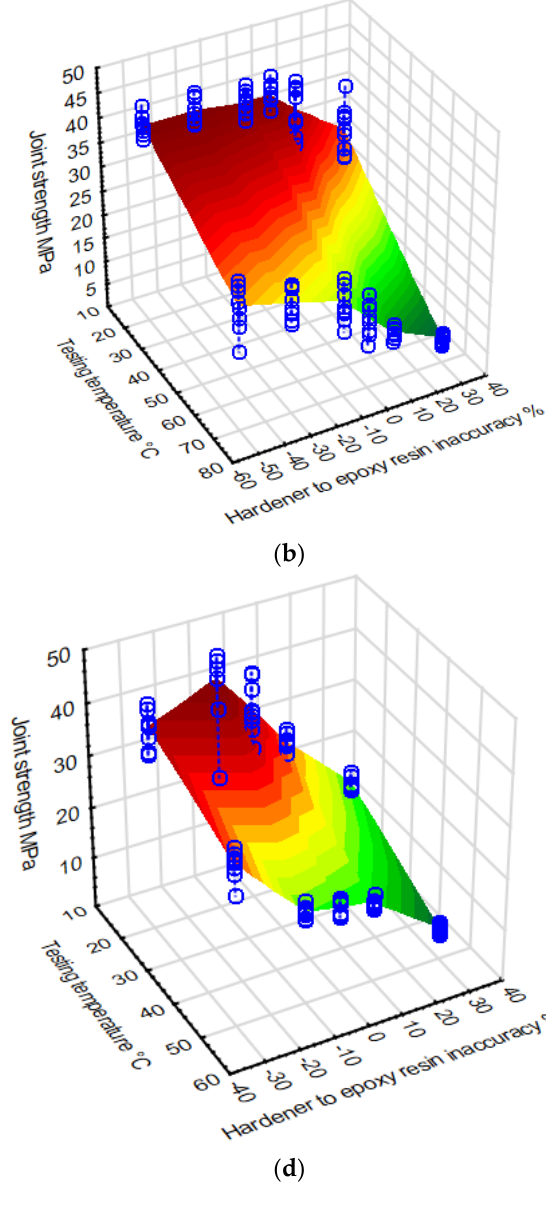
Figure 7. Strength of adhesive joints prepared using the presented adhesives crosslinked under dif- ferent thermal conditions: ( a ) Hysol 9492 cured for 3 days at 20 °C, ( b ) Hysol 9492 cured for 1 h at different thermal conditions: ( a ) Hysol 9492 cured for 3 days at 20 ◦ C, ( b ) Hysol 9492 cured for 1 h at 100 °C, ( c ) Epidian 57/PAC cured for 7 days at 20 °C, ( d ) Epidian 57/PAC cured for 2 h at 100 °C. 100 ◦ C, ( c ) Epidian 57/PAC cured for 7 days at 20 ◦ C, ( d ) Epidian 57/PAC cured for 2 h at 100 ◦